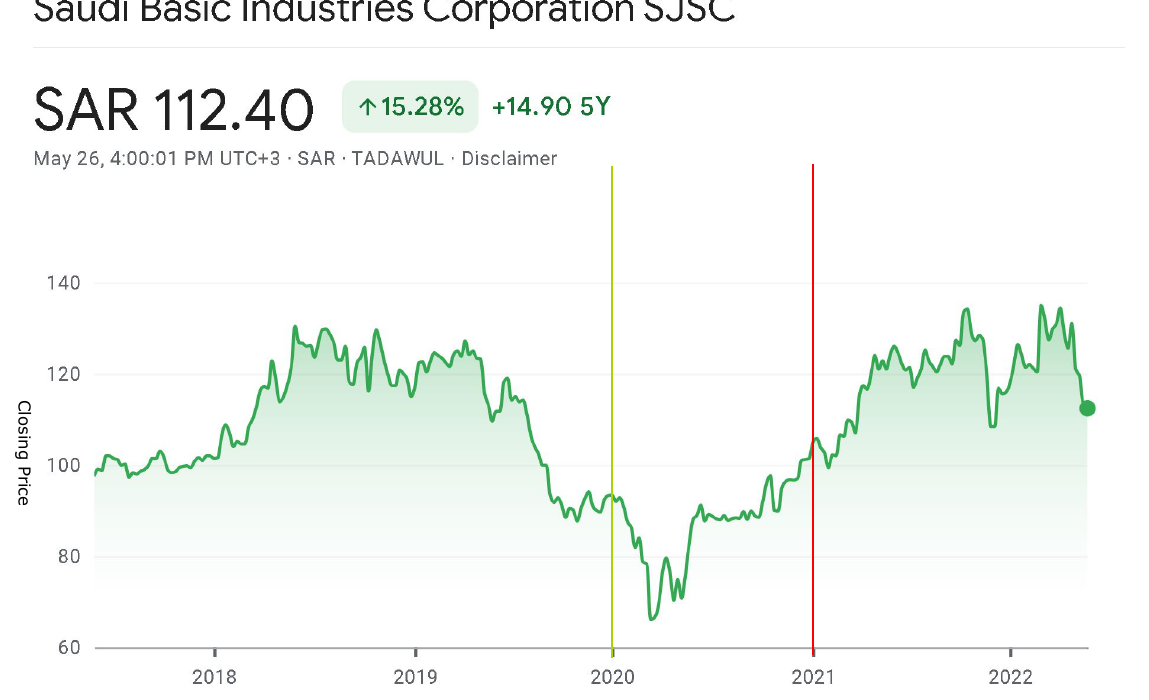
Figure 8. Behaviour of the Saudi Basic Industries Corporation (1020) during the training and testing